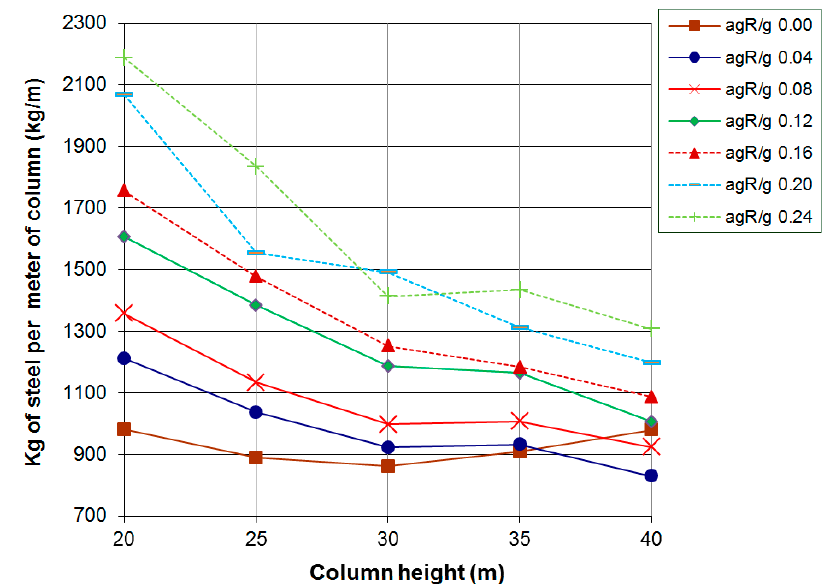
Figure 14. Steel reinforcement in the footing versus height of the column.